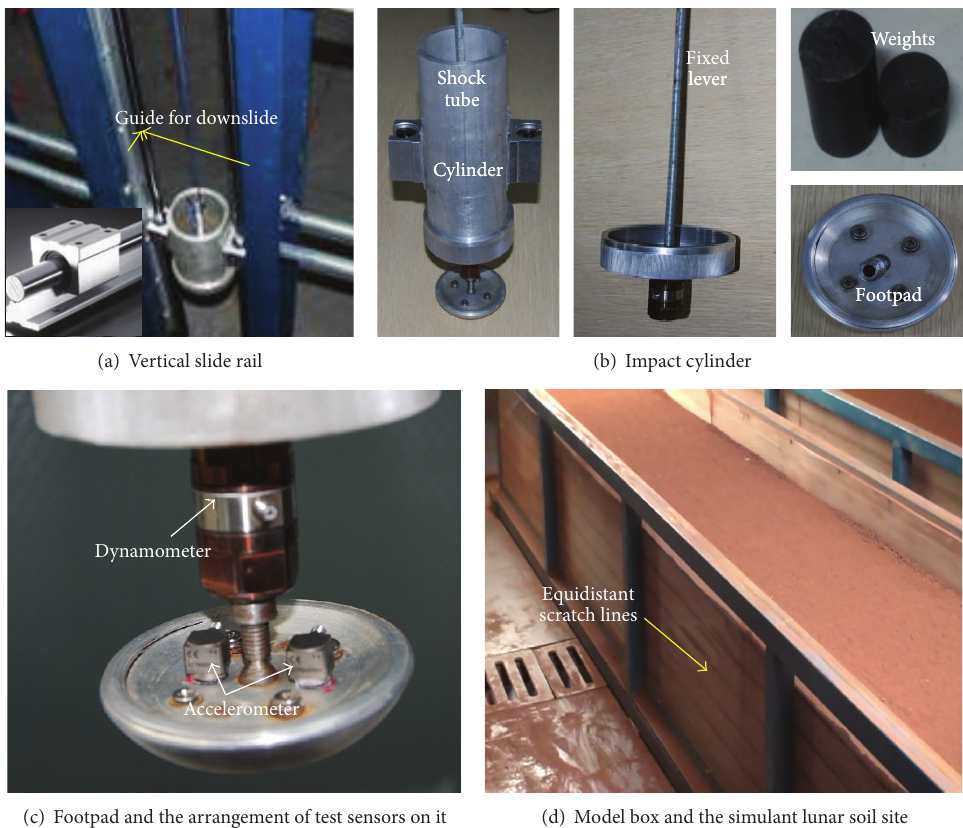
Figure 5: Detail of the apparatus component.